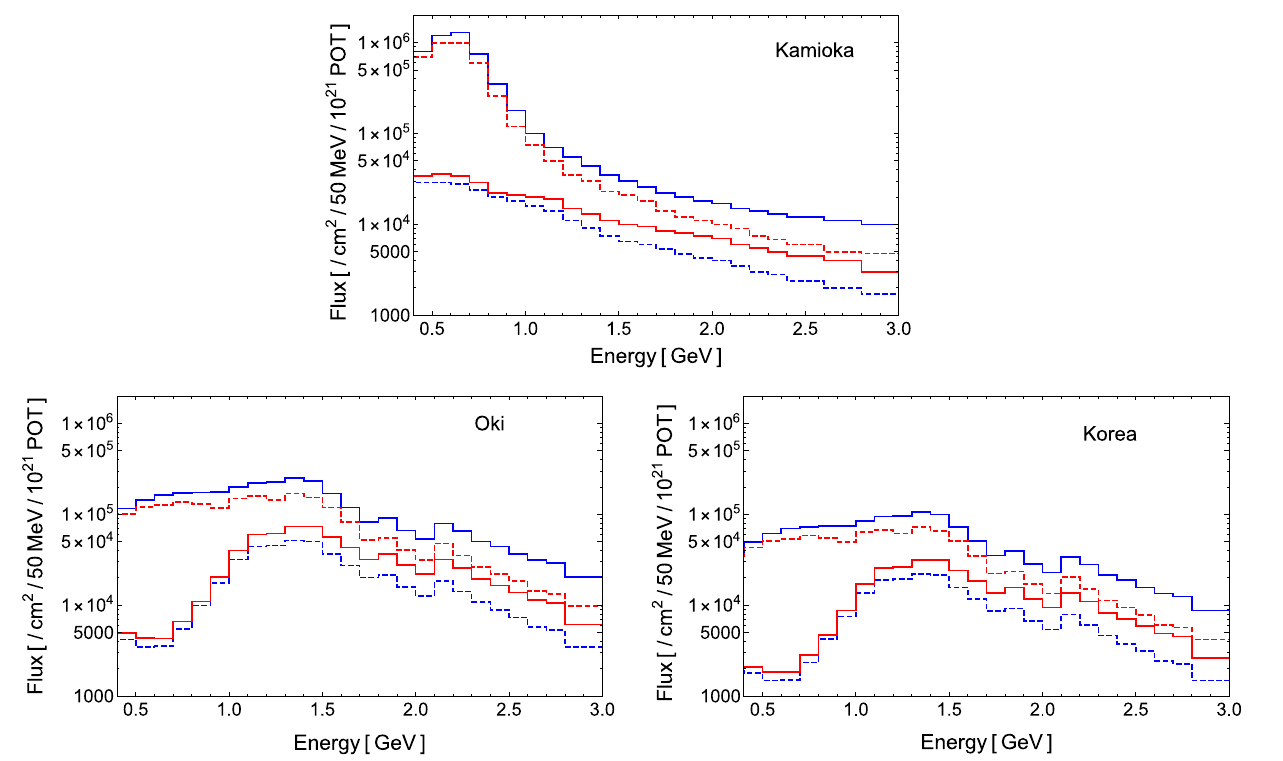
Fig. 9 Flux of ν μ and ¯ ν μ in neutrino-focusing and antineutrino- focusing beams detected at a water Cerenkov detector at Kamioka, Oki and in Korea if the neutrino oscillation were absent. The upper plot, the lower-left plot and the lower-right plot, respectively, correspond to